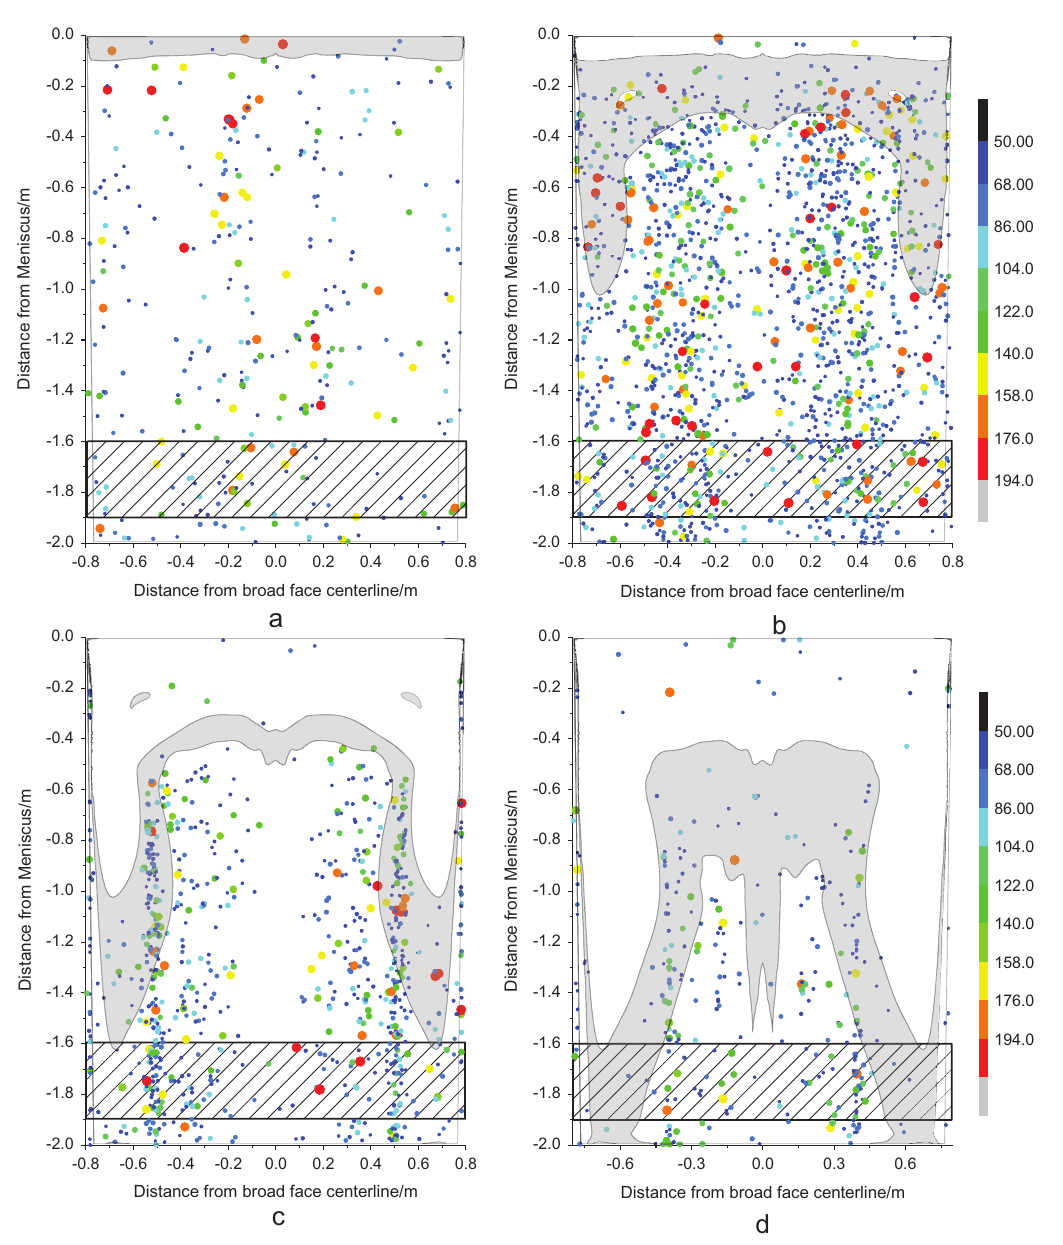
Figure 9: Inclusion distributions at different depths without considering the effect of the PDAS: 0~0.01m from broad surface (a) 0.01~0.02m from broad surface (b) 0.02~0.03m from broad surface (c) 0.03~0.04m from broad surface